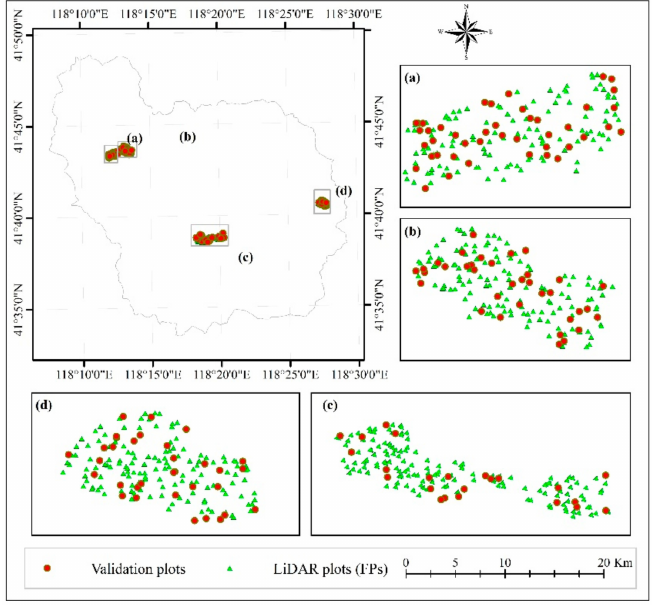
Figure 4. The validation and original samples extracted from LiDAR data (( a )–( d ) denote four partial